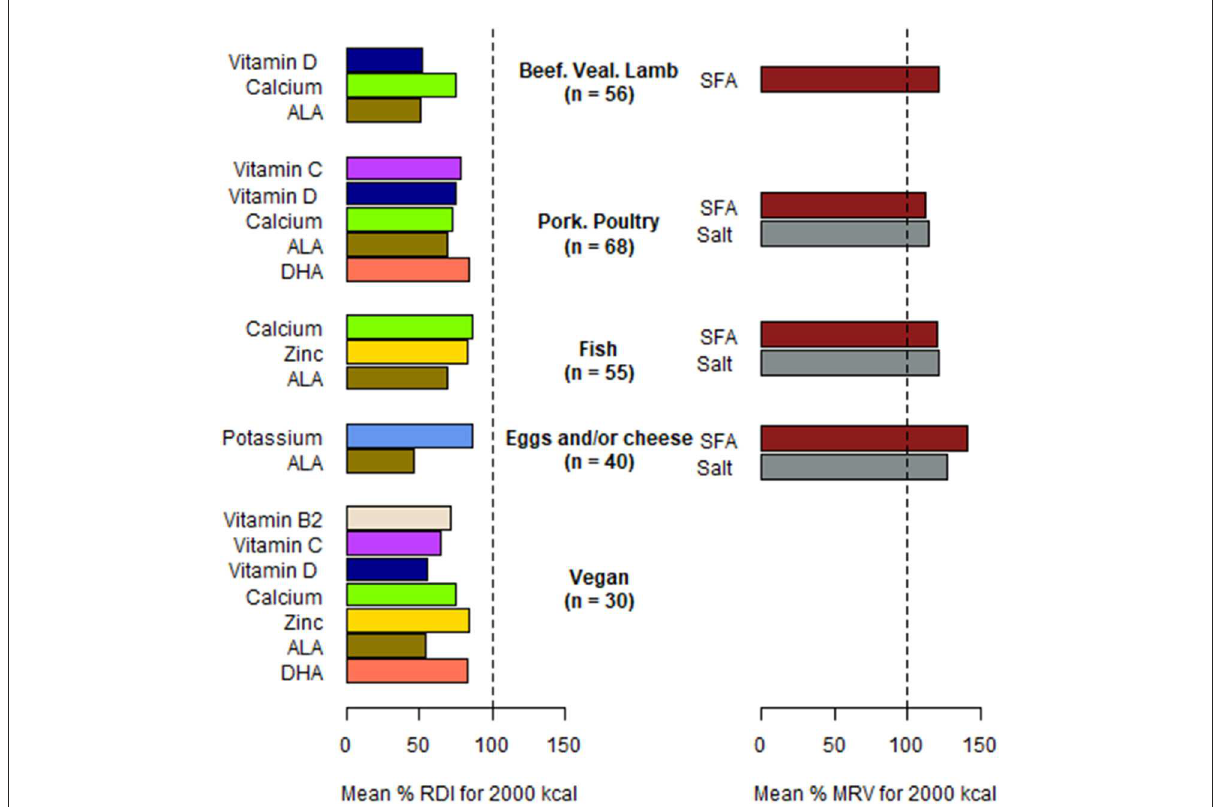
FIGURE1 Nutrients in deficit and nutrients in excess in five meal subcategories based on protein dish served in Dijon primary school canteens in 2019. Nutrients in deficit are significantly below RDI, p < 0.002; Nutrients in excess are significantly above MRV, p < 0.002. RDI, recommended daily intake. MRV, maximum recommended